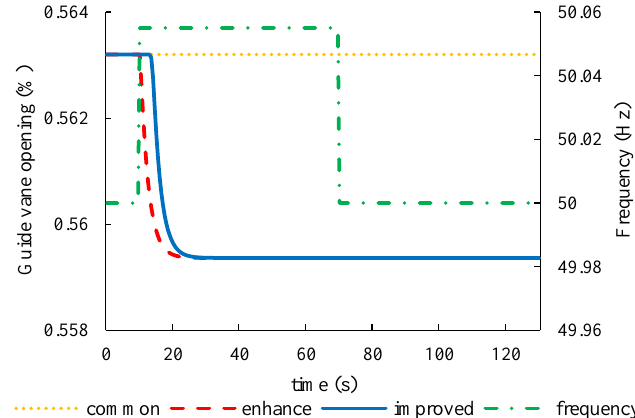
Figure 14. The guide vane opening curve of primary frequency control (PFC) with common, enhanced, and improved frequency dead zones.